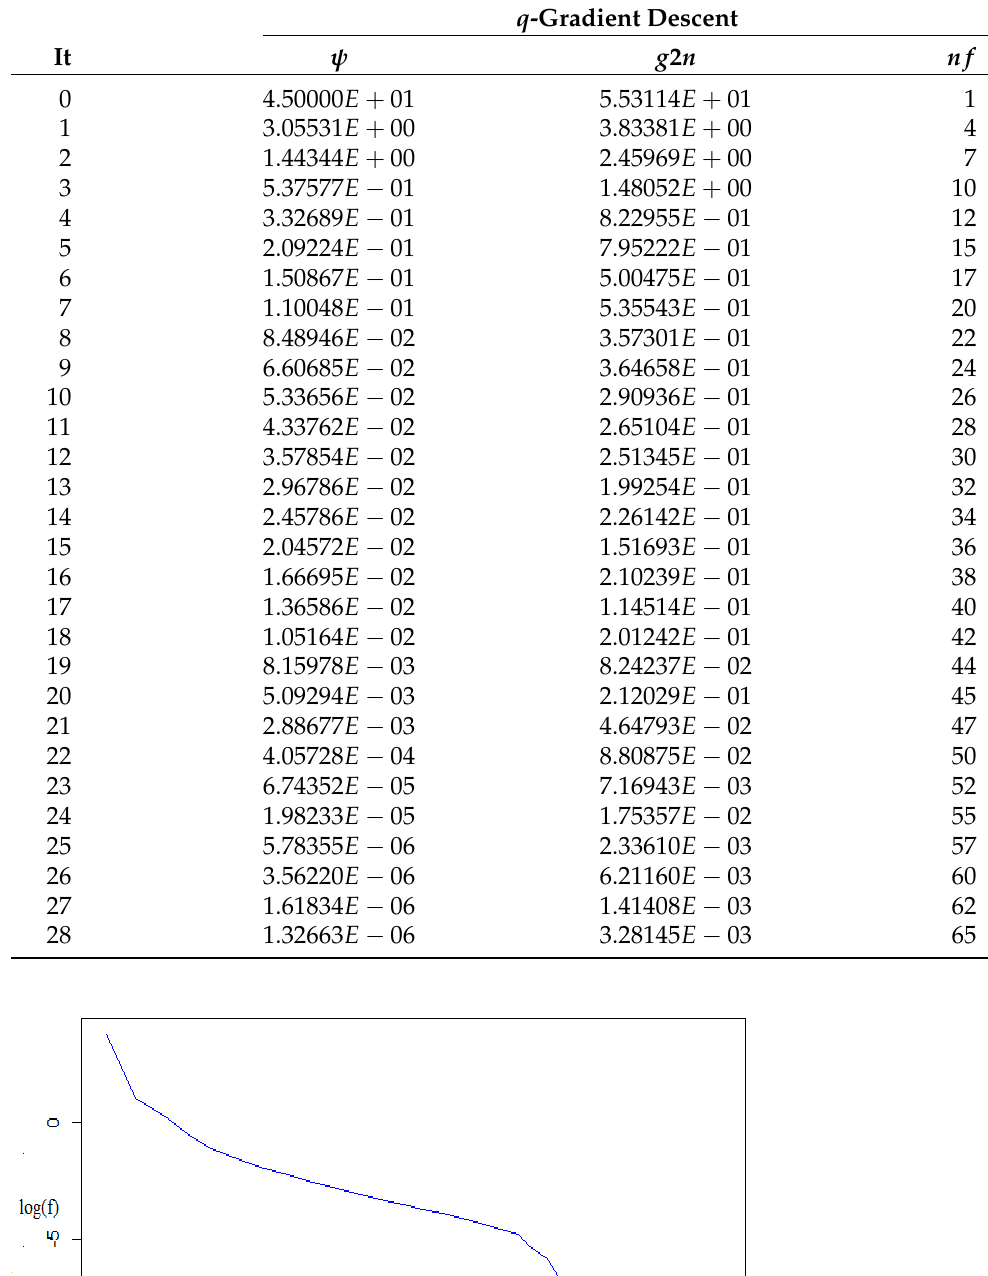
Table 2. Numerical output of Example 3 using Algorithm 1.